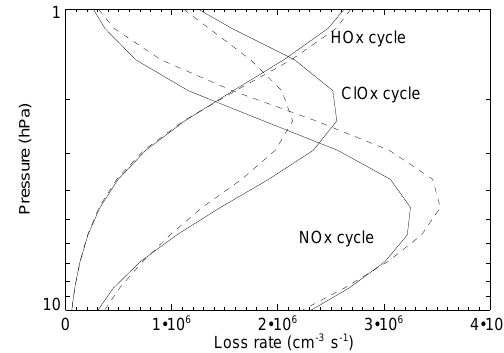
Figure 6. Altitude profiles of monthly and daily averaged ozone loss rates from WACCM/NOGAPS for June 2009 (solid) and June 2008 (dashed) at 75 ◦ N.